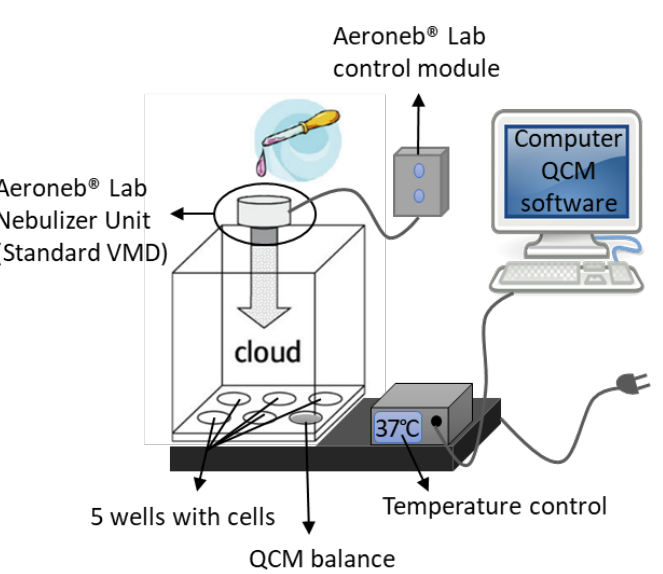
Figure 1. Schematic of the VITROCELL ® 6 Cloud device. The stainless-steel base module of this device comprises 5 electrically heated wells in which 13 mL of medium and the inserts are placed. The temperature in the wells is maintained at 37 °C. A sixth well contains a quartz crystal microbalance (QCM) for cell-delivered dose measurements with a resolution of 10 ng/cm 2 , at a sampling rate of 1 Hz and a manufacturer-specified zero noise level of 20 ng/cm 2 (VITROCELL ® Systems, Waldkirch, Germany), measurements are analyzed and visualized using the computer QCM software. The upper part of the device is a 2250 cm 3 polycarbonate removable exposure chamber pierced on the top with a hole to place the nebulizer. The nebulizer system is composed of the Aeroneb ® Lab Nebulizer Unit, Standard VMD and a Aeroneb ® Lab Control Module (Aerogen Inc., Galway, Ireland). The nebulization relies on a perforated piezoelectrically controlled vibrating mesh to generate acoustic pressure waves releasing liquid droplets at a high frequency (128 kHz). This nebulizer is constituted of a palladium mesh pierced with ca. 1000 holes, releasing between 0.3 and 0.8 mL of liquid per minute through the holes, resulting in a stream of droplets precisely controlled for size by the diameter of the apertures (4–6 µ m droplet diameter for the Standard VDM